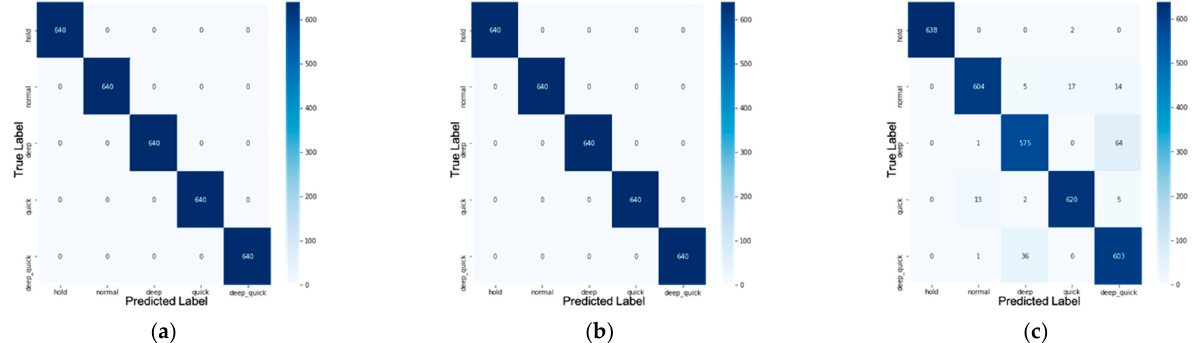
Figure 10. Confusion matrix for ( a ) raw data, ( b ) data with statistic feature extraction, and ( c ) data with MFCC feature extraction on training stage.